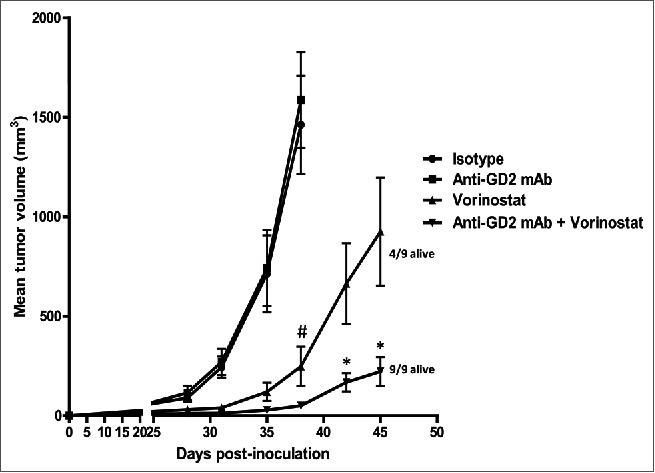
Anti-GD2 mAb and Vorinostat mediate synergistic anti-NBL effects in vivo. Immunocombination therapy using anti-GD2 mAb and Vorinostat results in synergistic inhibition of NBL tumor growth. (A) Mice were inoculated s.c. with 1 × 106 9464D cells on day 0. Anti-GD2 mAb therapy (200 μg/mouse, i.p.) was initiated on day 8 and repeated twice weekly. Vorinostat treatment (150 mg/kg, i.p.) was initiated on day 14 and given for 3 consecutive days and this scheme was repeated weekly until day 45. Tumor growth was monitored and tumor volumes were calculated. Occasionally (< 5% of all mice), tumors caused skin ulceration which was randomly divided over the treatment groups; these mice were sacrificed and excluded from the analysis. Mean tumor volumes for each treatment group (9 mice/group) are depicted (#p < 0.05 for isotype or anti-GD2 vs. Vorinostat or Vorinostat + anti-GD2) (*p < 0.05 for Vorinostat vs. Vorinostat + anti-GD2). On day 45, 9/9 mice of the anti-GD2 plus Vorinostat group, whereas 4/9 mice of the Vorinostat monotherapy group were still alive (defined by tumor volume < 1000 mm3). Representative data of two independent are shown.